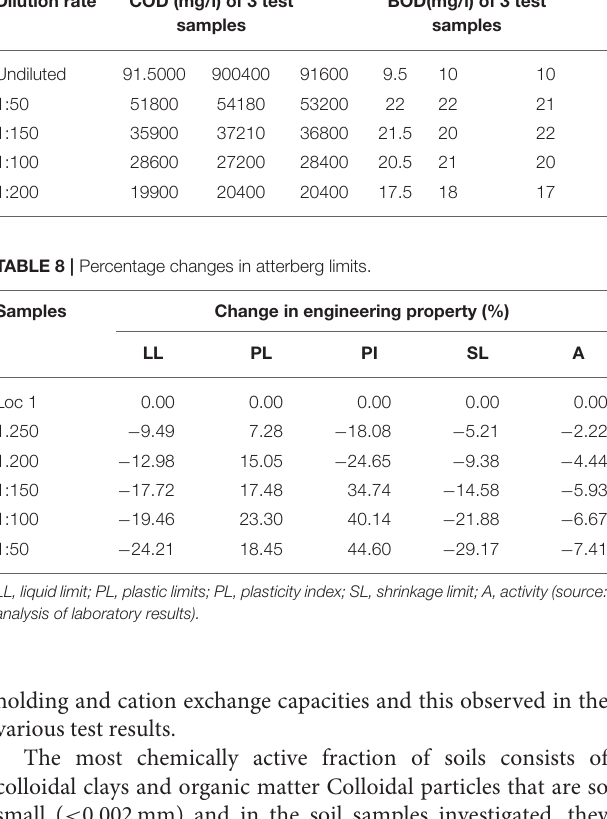
TABLE 7 | Organic matter content of nanomaterial reagent at different concentrations. Dilution rate COD (mg/l) of 3 test samples